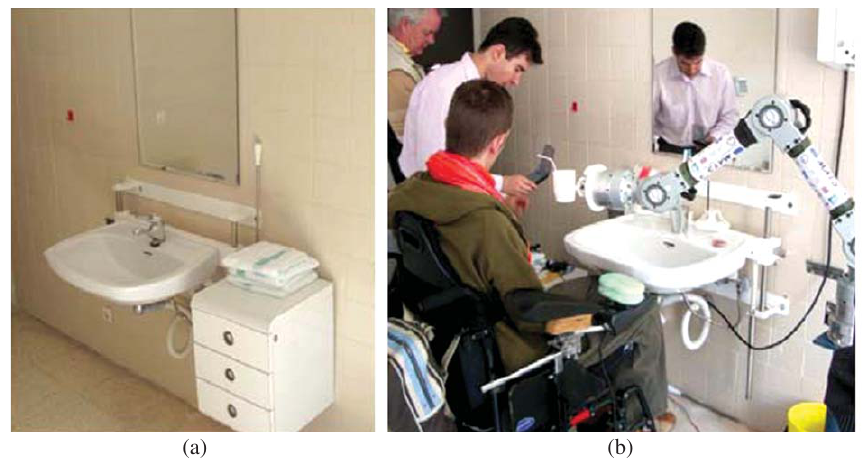
Fig. 6. Bathroom scenario: before adaptation (a) and after adaptation